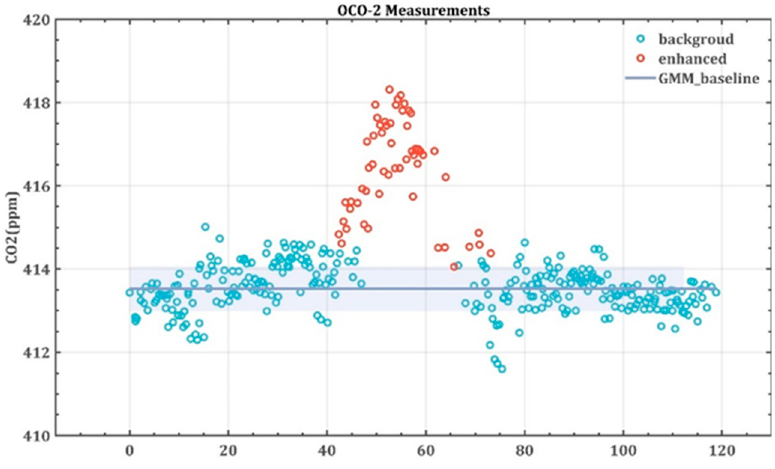
Figure 5. Measurement trajectory.